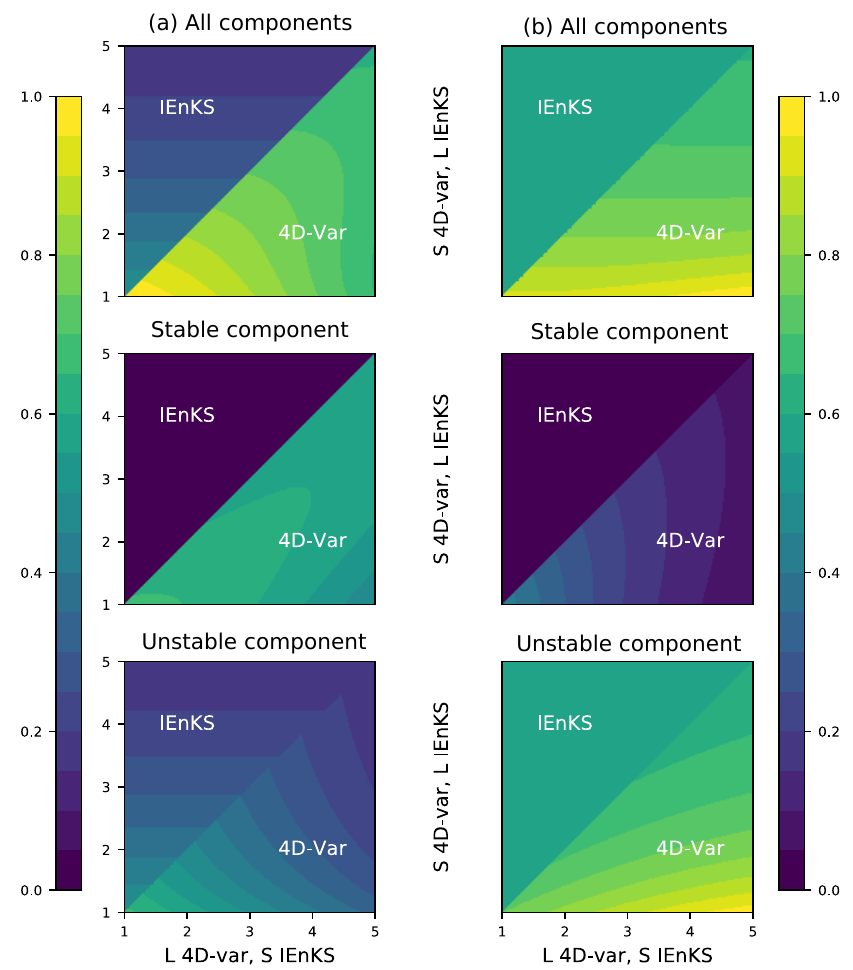
Figure 3. The asymptotic smoothing (a) and filtering (b) eMSEs of 4D-Var and the IEnKS. eMSEs are displayed as functions of L,S with their components on the stable and unstable subspaces. The L parameter is on the abscissa axis for 4D-Var and on the ordinate axis for the IEnKS. The S parameter is on the abscissa axis for the IEnKS and on the ordinate axis for